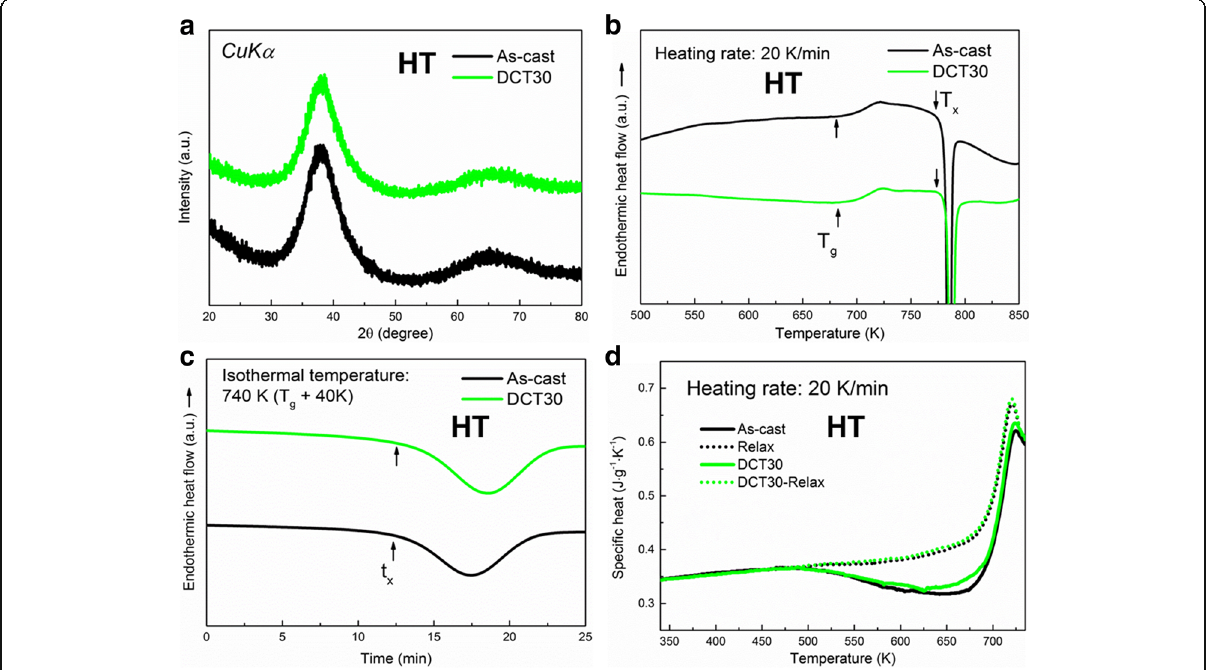
Fig. 1 a XRD and b DSC curves of both As-cast and DCT30 samples cast at HT, c heat-flow as a function of time during isothermal annealing (740 K), and ( d ) specific heat of both As-cast and DCT30 samples cast at